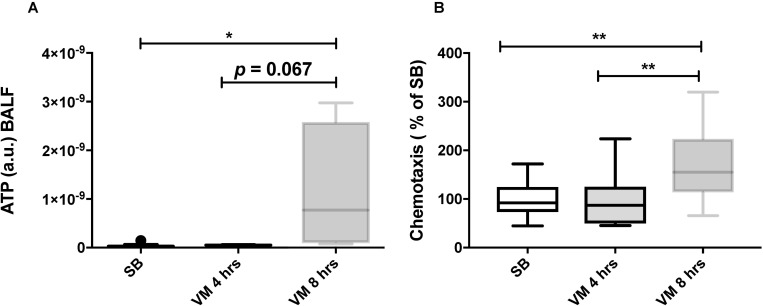
BAL fluid from ventilated rabbits presents elevated ATP level and has chemotactic activity.(A) Extracellular ATP measured in bronchoalveolar lavage (BAL) fluid from rabbits submitted to mechanical ventilation for 4 and 8 hours and in spontaneously breathing animals. (B) Chemotactic activity of BAL fluid from rabbits submitted to mechanical ventilation for 4 and 8 hours and in spontaneously breathing animals. Human primary neutrophil chemotaxis was measured in a 96-well Boyden chamber and expressed as percentage migration compared to SB. Data represent median with interquartile range of at least three independent experiments. *P < 0.05, **P < 0.01, Kruskall-Wallis test with FDR correction (A-B). MV: mechanical ventilation, SB: spontaneously breathing.